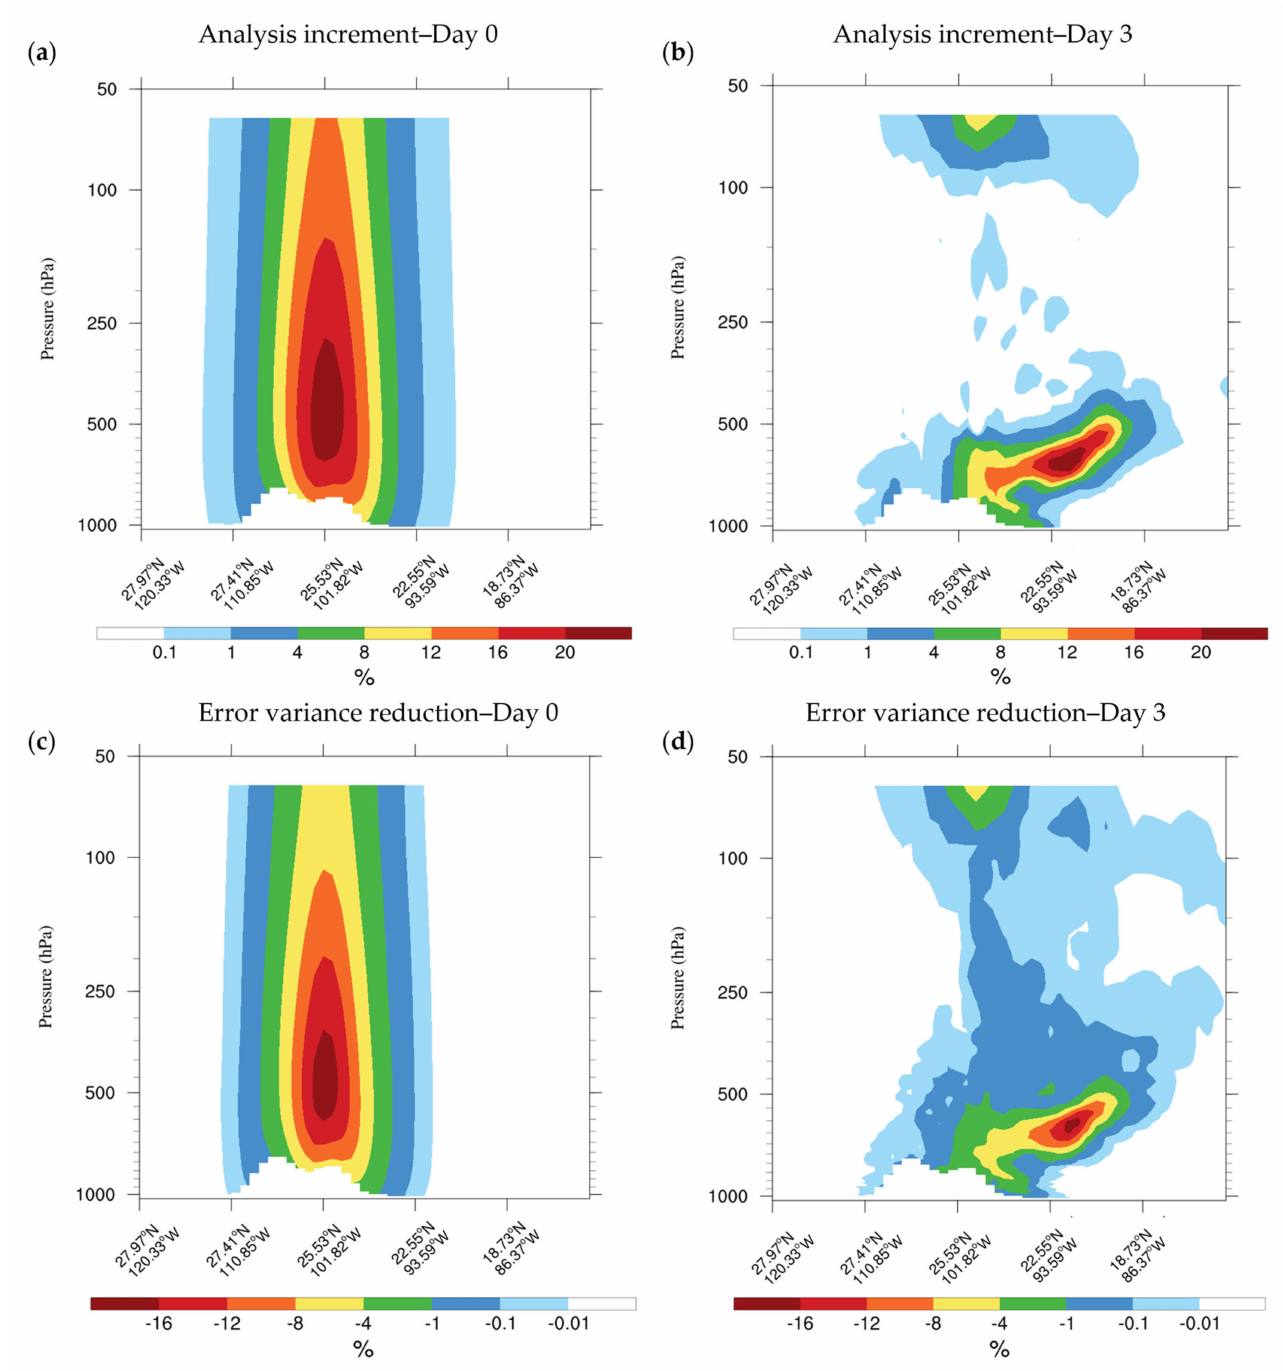
Figure 8. Vertical distribution of ( a ) analysis increment at Day 0 and ( b ) Day 3 along the cross-section (black dashed line) shown in Figure 7a,b; Vertical distribution of ( c ) error variance reduction at Day 0 and ( d ) Day 3 along the cross-section (black dashed line) shown in Figure 7c,d. The cross-section starts from ( 28 ◦ N,120 ◦ W ) to ( 15 ◦ N,80 ◦ W )